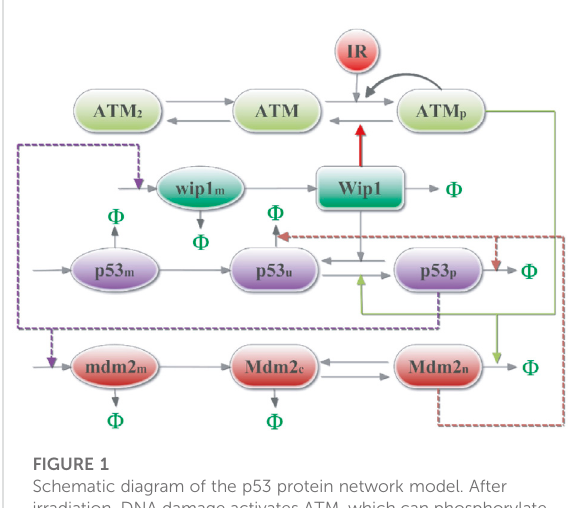
Schematic diagram of the p53 protein network model. After irradiation, DNA damage activates ATM, which can phosphorylate and accelerate the degradation of nuclear Mdm2, thereby stabilizing and activating p53 phosphorylation. Then, p53 will induce the production of Mdm2 and Wip1, while Wip1 can dephosphorylate ATM and p53 in turn. The symbol Φ represents the degradation